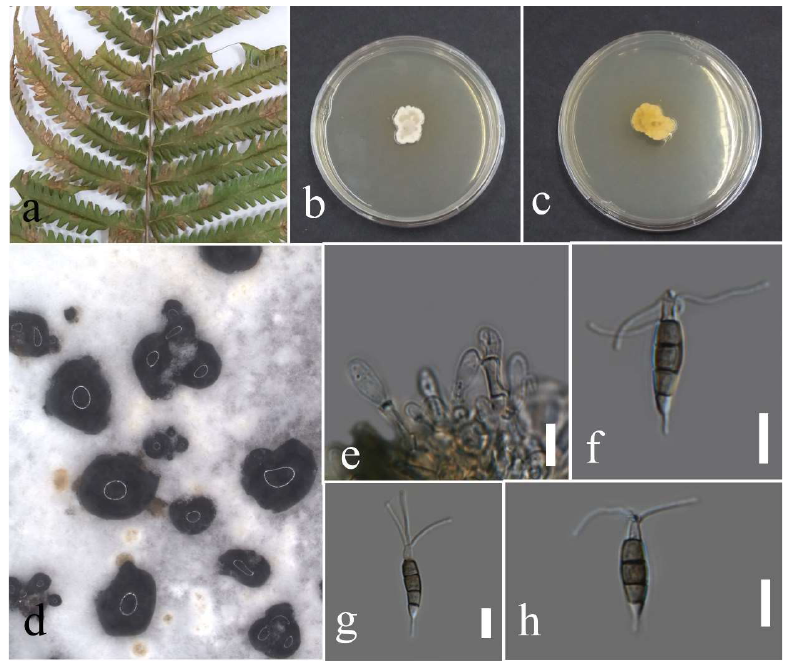
Figure 9. Morphology of Neopestalotiopsis pandanicola based on the isolate MFLUCC 22 - 0144: ( a ) leaf spot in Cyclosorus sp . ; ( b , c ) upper and reverse views of the colony after seven days of growth on PDA at 28 °C; ( d ) conidiomata; ( e ) conidiogenous cell; ( f – h ) conidia . Scale bars = 10 µm . Neopestalotiopsis phangngaensis Tibpromma & K . D . Hyde, 2018. Facesoffungi number: FoF 04527; Figure 10.